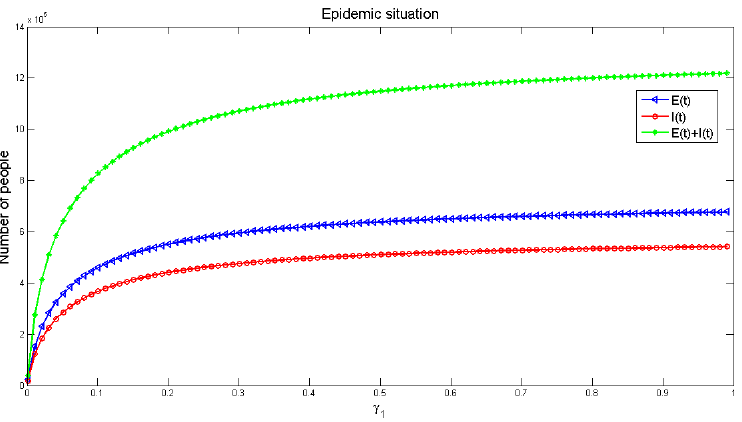
Figure 12. The influence of indirect infection factor γ 1 on the number of infected people.